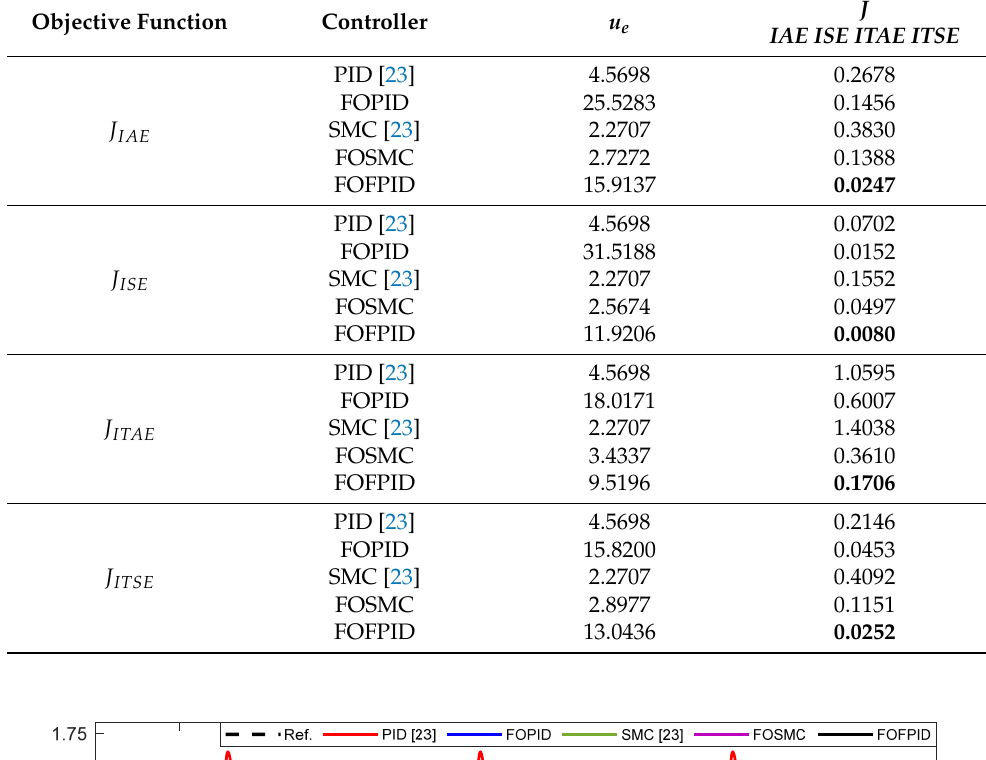
Table 5. Comparison of control energy and objective function values for different controllers.